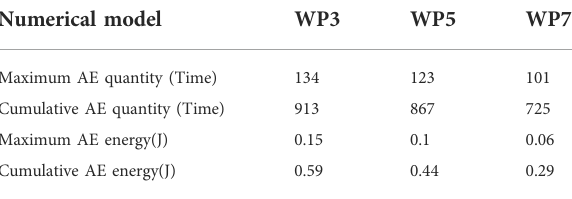
TABLE 2 AE values of different lower boundaries water pressure samples with the same